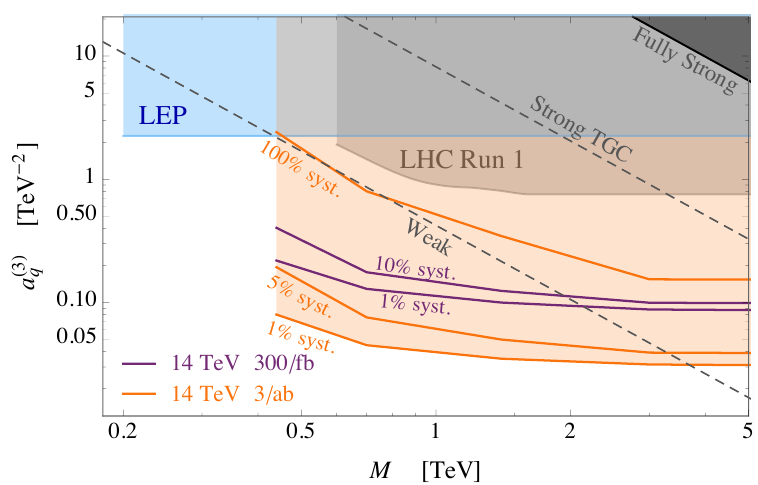
1 at 8 TeV and 3 fb 1 at (cid:0) (cid:0)